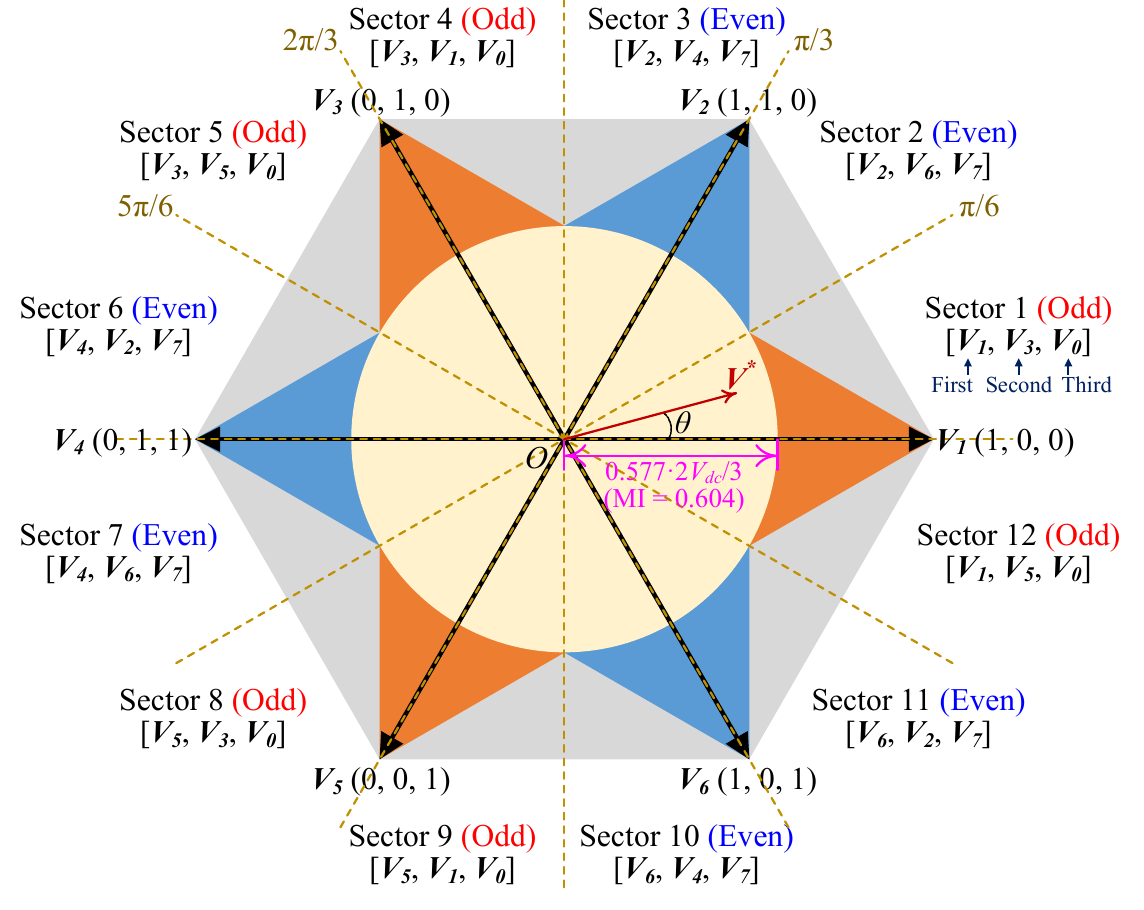
Figure 4. Voltage vector diagram of proposed method at MI ≤ 0.604.